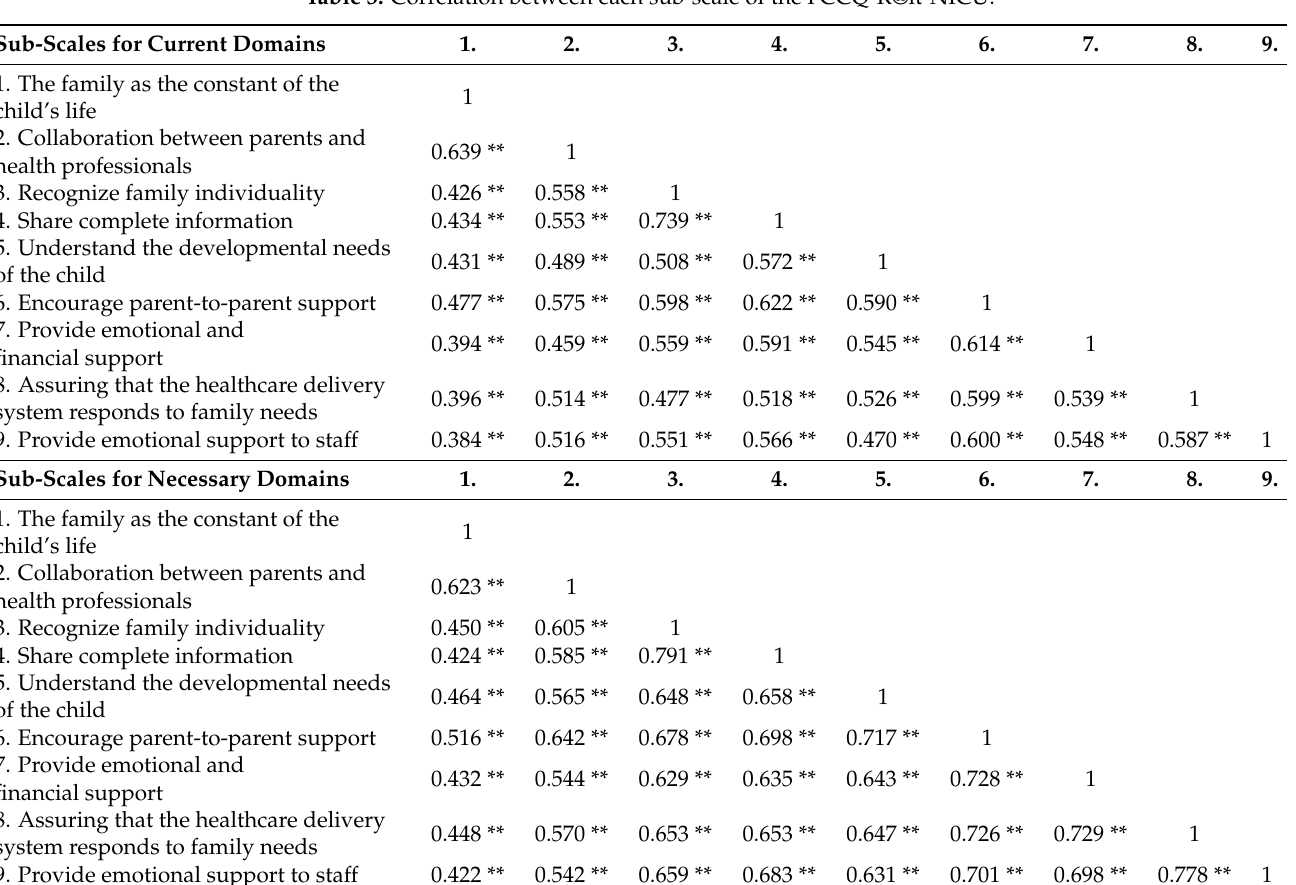
Table 3. Correlation between each sub-scale of the